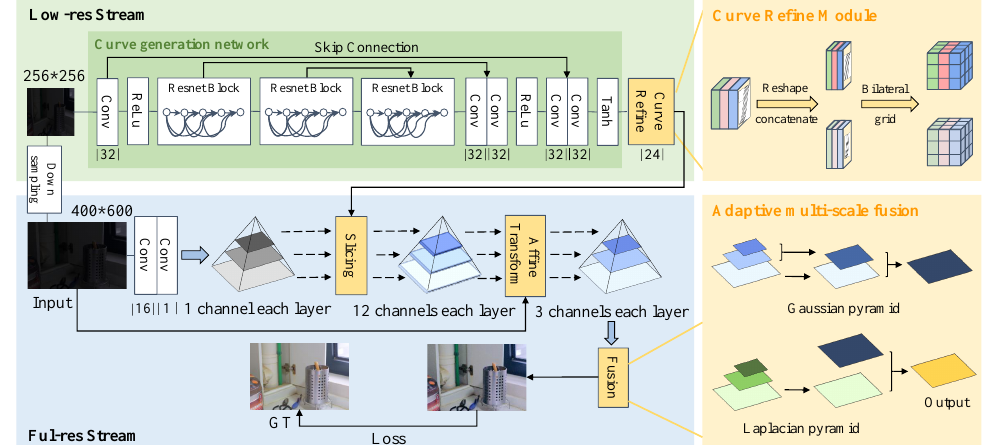
Figure 2. overall framework of LIMPID consists of two streams. The low-resolution stream maps the downsampled input to image-specific curves with parameter information stored in two bilateral grid volumes. Then, the full-resolution stream constructs a gray-scale Gaussian pyramid as a guide map for slicing, and upsamples the curve parameter information to full resolution. Finally, the full-resolution output is obtained after boosting the color and texture with adaptive multi-scale